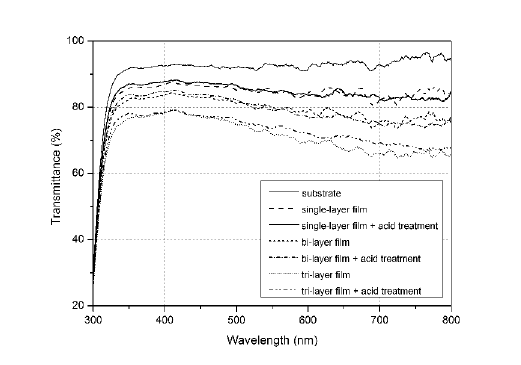
Figure 5. Optical transmittance of untreated and sulfuric acid treated DMSO-doped PEDOT:PSS films Dependence of average sheet resistance on the number